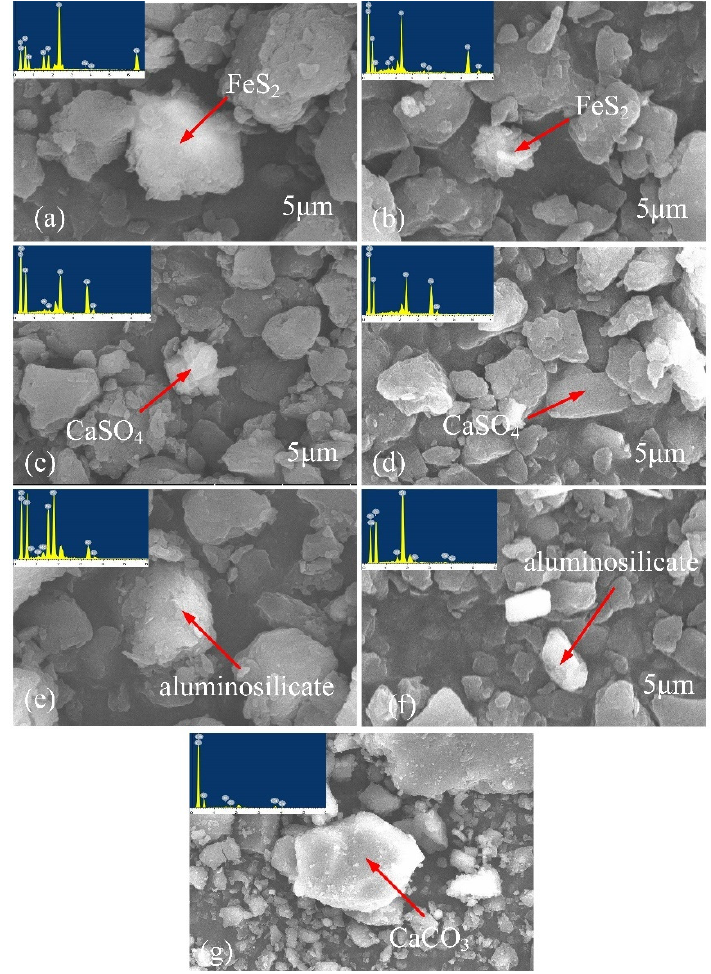
Figure 2. SEM-EDX images of minerals in NMH ( a , c , e , g ) and GL ( b , d , f ) coal.